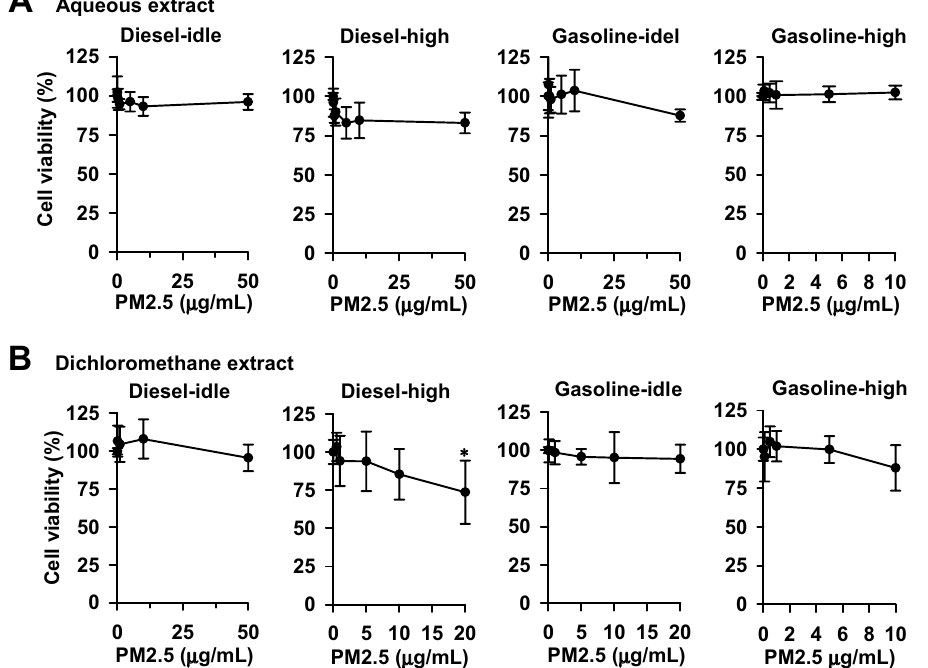
Figure 4. The influences of the aqueous ( A ) and dichloromethane ( B ) extracts of PM 2.5 particulates on cell viability in A549 cells. After seeding, cells were cultured for 24 h and then exposed to the extracts of particulates for 48 h. Cell viability was monitored using MTT reduction assay as described in the Methods. Data represent the means ± SD of three separate experiments with triplicate determinations in each experiment. * p < 0.05 with a decrease >